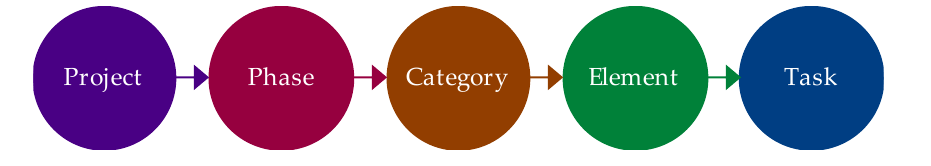
Figure 2. Hierarchical structure of the cost.